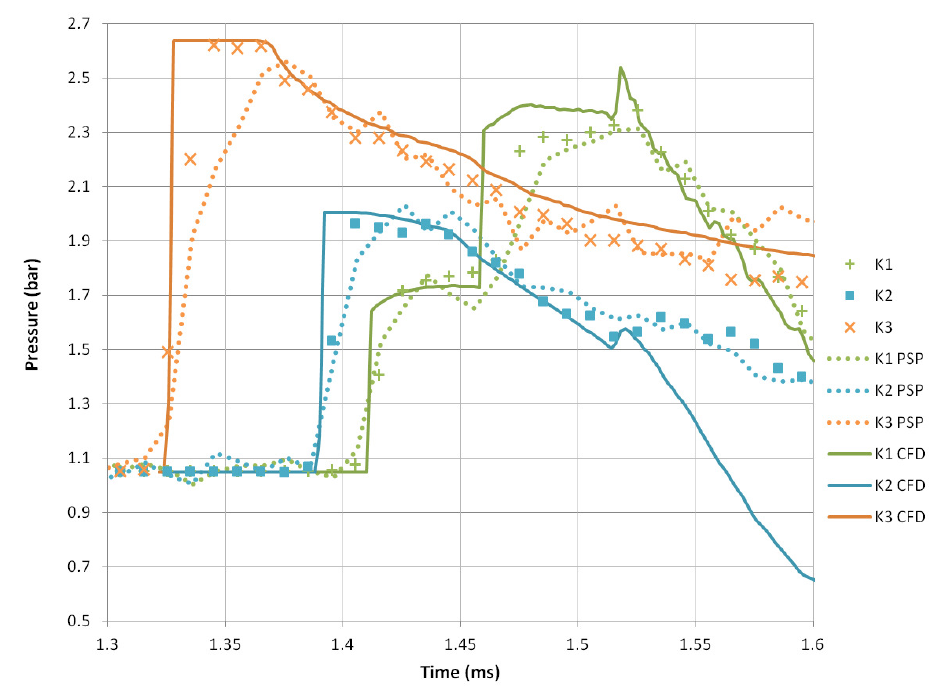
Figure 12. Pressure transducer measurements of M sharp